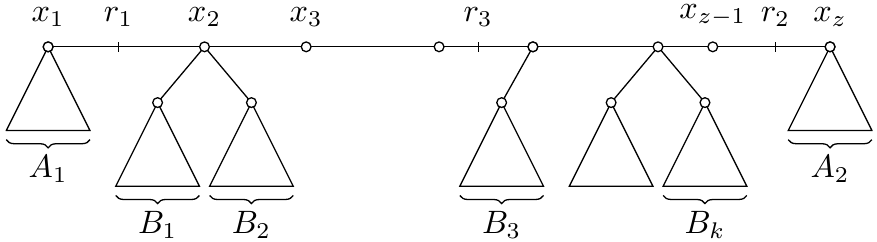
Figure 6. The path containing r 1 , r 2 and r 3 in tree S . Leaves are partitioned into sets A 1 , A 2 and B , where B is in the figure represented by the union B 1